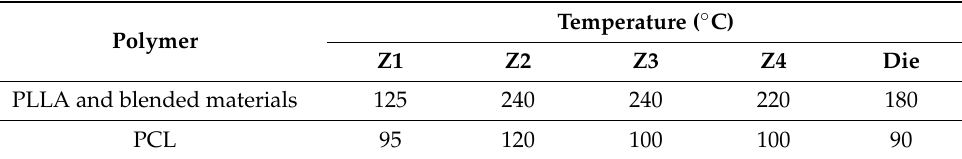
Figure 1. Schematic of extruder with temperature zones. Table 1. Extrusion temperatures for each of the 5 temperature Table 1. Extrusion temperatures for each of the 5 temperature zones.